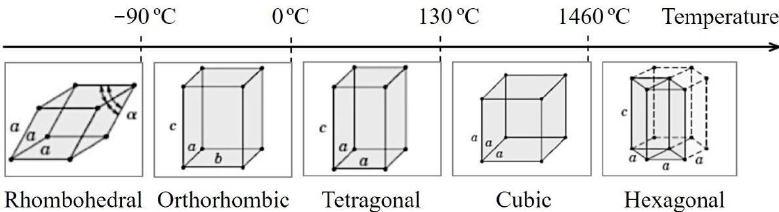
Figure 1. Phase transformations of the BaTiO 3 crystal at different temperatures.